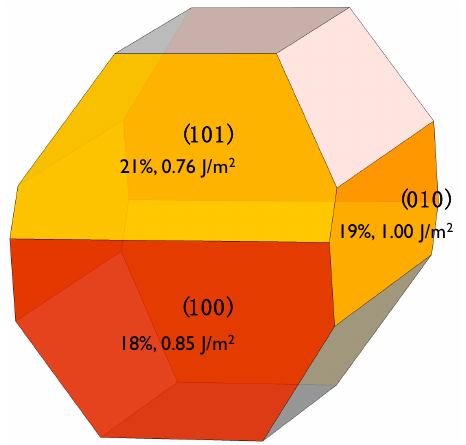
Figure A1. Wulff shape reconstruction of β -C 2 S, according to the surfaces energies computed in Reference [28]. The three studied surfaces are colored and the label shows their cleavage, their contribution to the total surface, and their surface energies. The shape reconstruction and the contribution of each surface to the total area of the crystal has been obtained from the VESTA code [35].